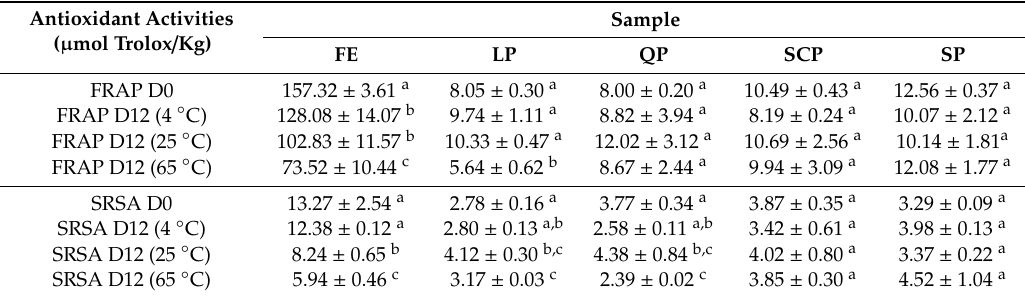
Table 2. Comparison of the antioxidant activity of free and encapsulated annatto extracts stored under di ff erent